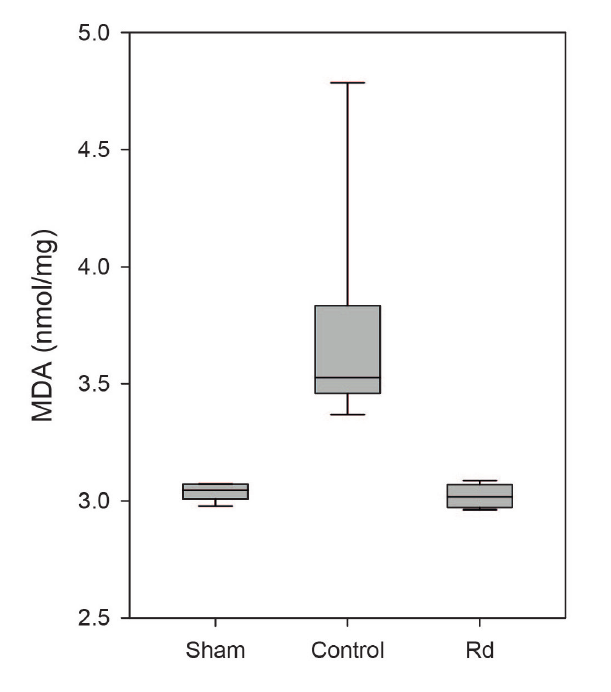
Fig. 4A - Boxplot of malondialdehyde (MDA) levels in each group. Significantly higher MDA levels were observed in the control group compared to the sham group (P<0.001). Significantly lower MDA levels were observed in the Rd group compared to the control group (P<0.001). No significant difference was observed between the Rd and sham groups (P>0.05).